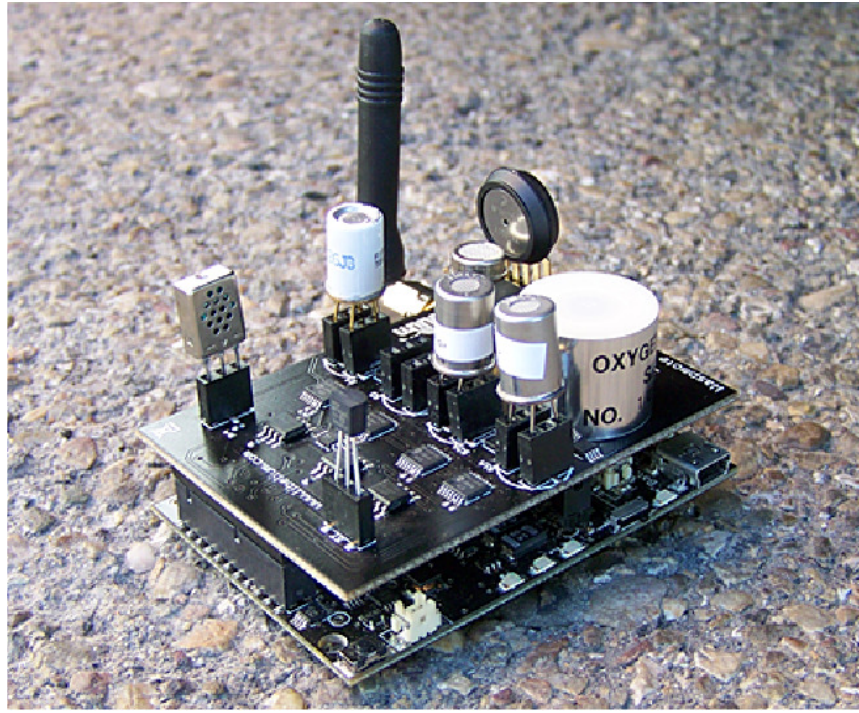
Figure 8. The Gas Sensor Board (courtesy of